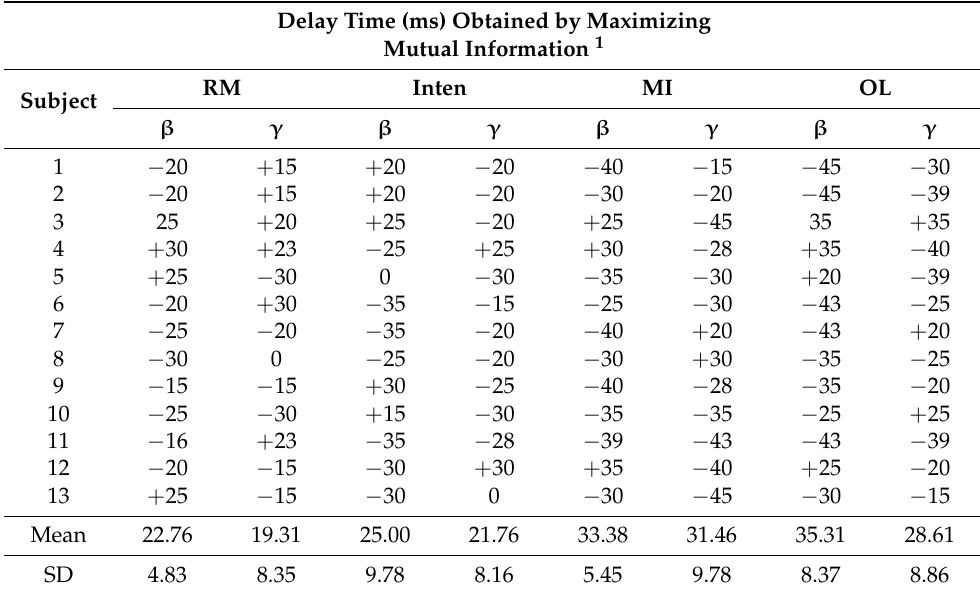
Table 1. Summary of the delay time in the beta band and gamma band across all motor tasks. Delay Time (ms) Obtained by